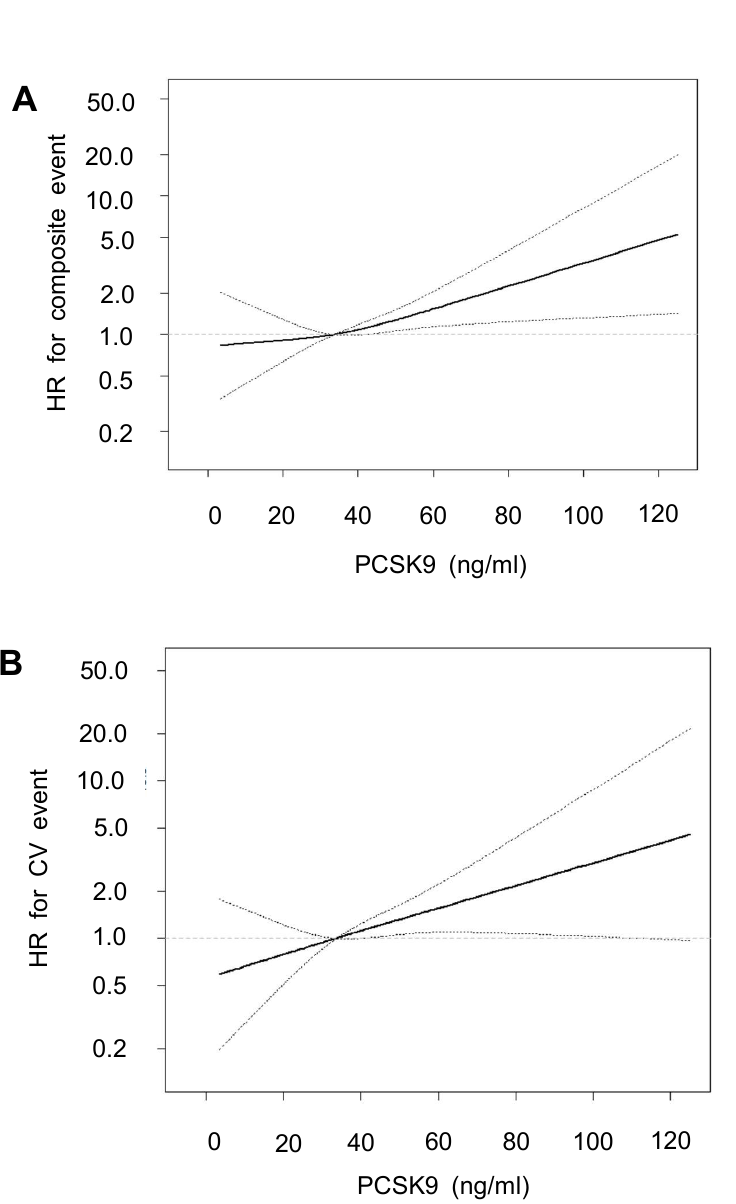
Figure 2. Linear associations of PCSK9 and risk of composite ( A ) and of CV event ( B ) after multiple adjustments. Dashed lines represent 95% confidence intervals. The adjusted multiple variables were age, sex, BMI, Charlson comorbidity index, dialysis duration, spKt / V , catheter use, hemoglobin, serum glucose and albumin, log hsCRP, statin use, total cholesterol, and LDL cholesterol.